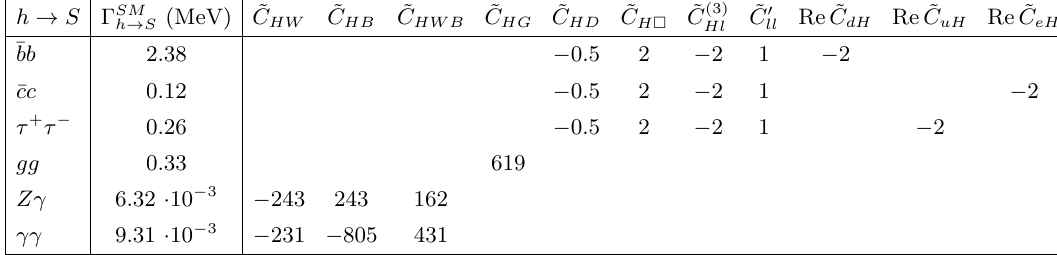
Table 7 . Partial SM Higgs decay width and coe(cid:14)cients a ( S )